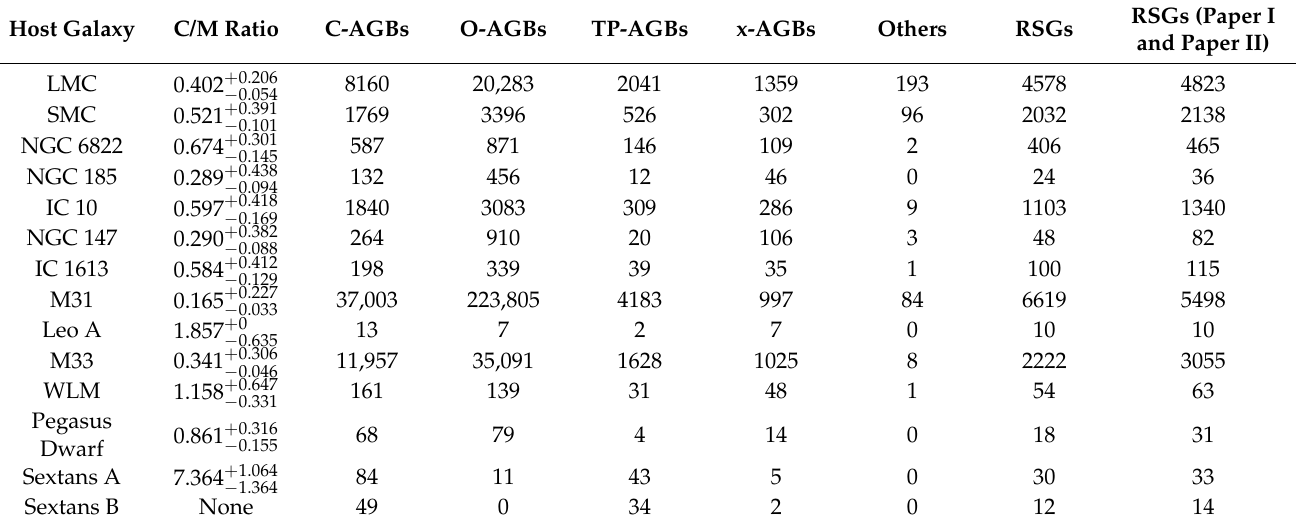
Table 3. The C/M ratio, and number of various types of stars in the 14